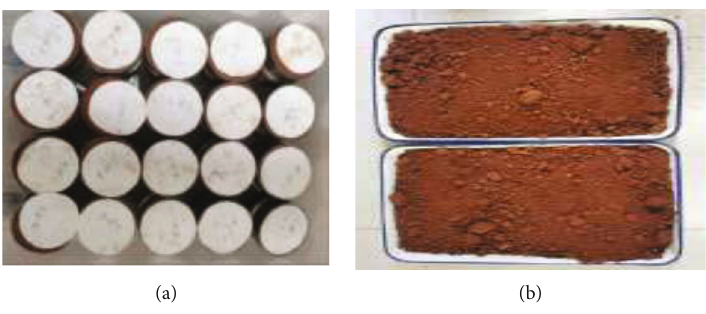
Figure 3: (a) Specimens of mechanical tests. (b) Red clay. Table 2: The compressibility indexes of con fi ned compression